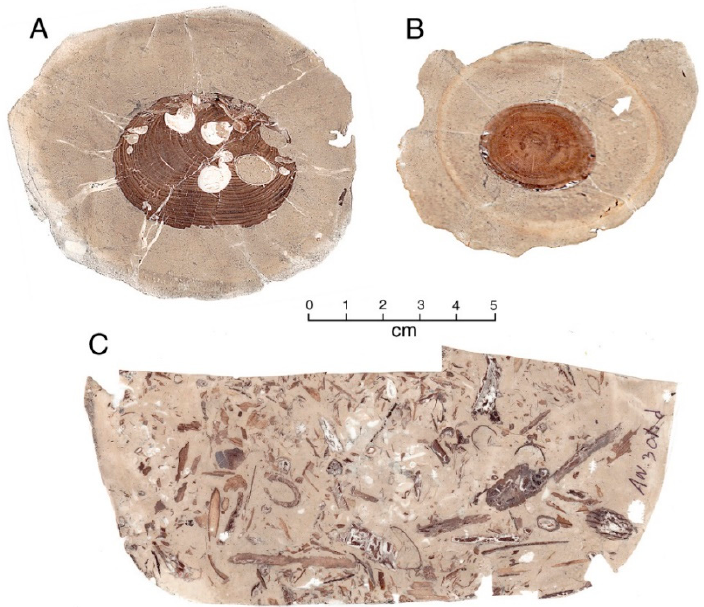
Figure 4. Acetate peels from Lower Cretaceous calcareous concretions from Apple Bay. ( A ) Transverse view of wood containing teredo borings. ( B ) Transverse view of limb, showing concentric zonation of concretionary matrix (arrow). ( C ) Concretion containing fragmental plant remains.